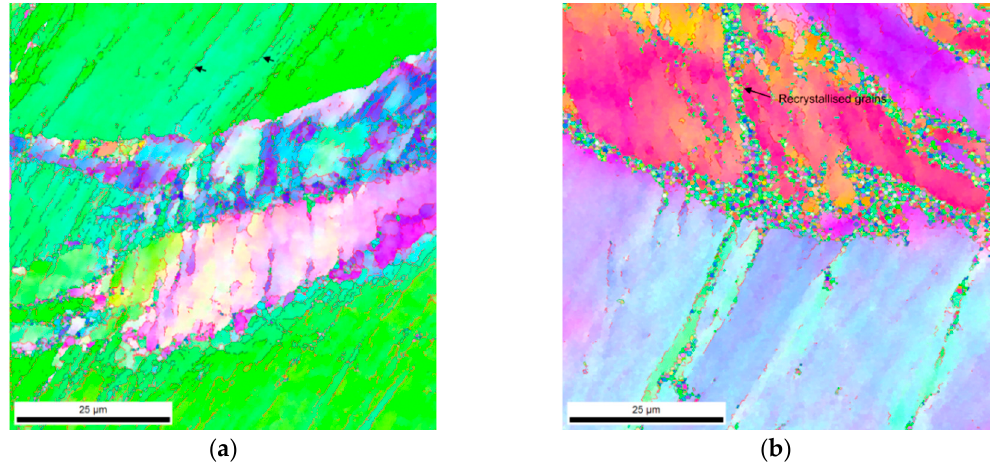
Figure 5. Electron backscatter diffraction (EBSD) IPF (Inverse Pole Figure) maps achieved from the centre region of the specimens (cross-section view) ( a ) ST + ECAP 2× + ageing 160 °C for 4 h and ( b ) ST + ECAP 2× + ageing 180 °C for 4 h.